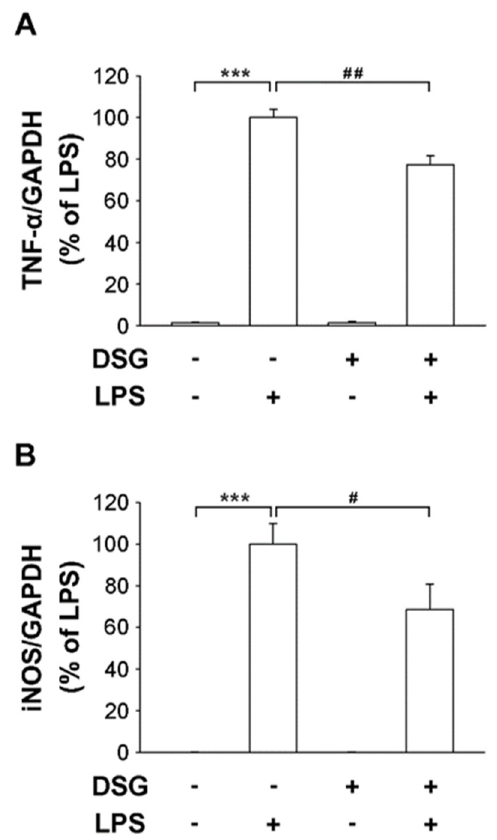
Figure 2. Effects of diosgenin on the LPS-induced release of proinflammatory cytokines from primary rat microglia. Primary rat microglia were treated with vehicle or diosgenin (2 µM) for 30 min before treatment with or without LPS (25 ng/mL) for 4 h. The expression levels of TNF- α ( A ) and iNOS ( B ) measured using real-time RT-PCR were normalized to GAPDH. The results are reported relative to LPS-treated cells as the means ± SD obtained from three independent experiments using different batches of isolated cells. *** p < 0.001 compared with the control; # p < 0.05 and ## p < 0.01 compared with LPS-treated cultures.